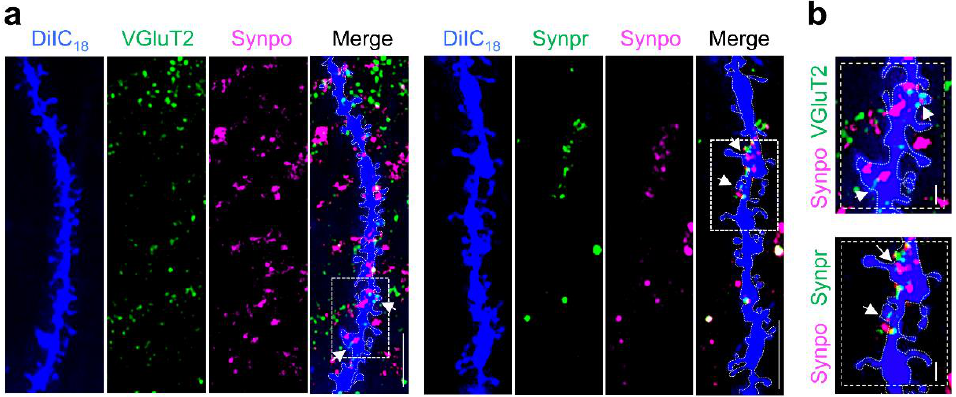
Figure 2. Visualization of Synpo-containing spines and VGluT2- or Synpr-positive terminals at hippocampal synapses ex vivo. ( a ) Representative confocal images of WT hippocampal dendrites stained with DiIC 18 and labeled with anti-Synpo together with either anti-VGluT2 (left panels) or anti-Synpr (right panels). Shown are individual channels (DiIC 18 in blue) and the overlay of the three channels (Merge); boxed areas are shown magnified in ( b ), scale bars 5 µm. ( b ) Magnified images of boxed areas in ( a ); scale bars, 2 µm. Arrows point to regions of Synpo/VGluT2 or Synpo/Synpr overlap.